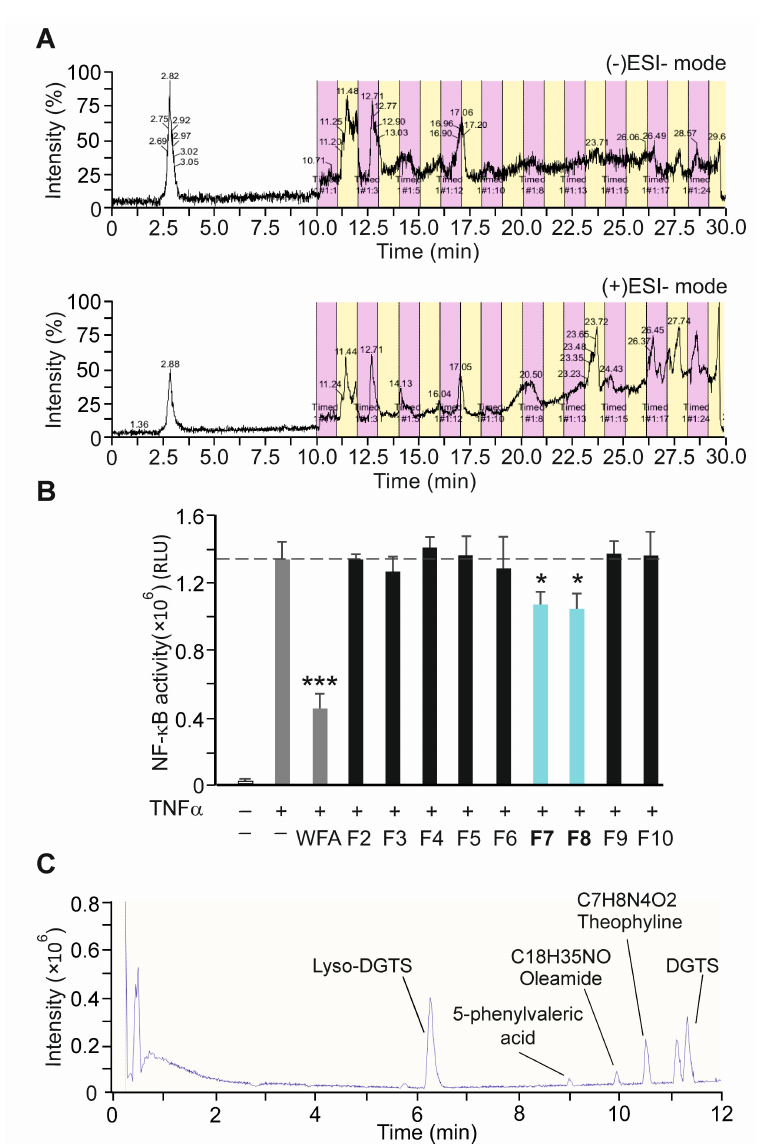
Figure 6. Bioactivity-guided fractionation of NAE_2022C and the detection of major metabolites. ( A ) Total ion HPLC-MS chromatograms of crude 2022C extract. Colored bars indicate collected fractions and corresponding peaks in positive and negative ( − )ESI and (+)ESI MS ionization modes. ( B ) The bioactivity of NAE_2022C fractions (F2–F10; 1 µ g mL − 1 ) were analyzed with the NF- κ B reporter cell-based assay, as shown in Figure 2B. Data represent means ± SD of three independent biological triplicates. * p < 0.05; *** p < 0.001 vs. samples treated with DMSO and TNF α . ( C ) UHPLC and mass spectrometry analysis of NAE_2022C active fraction (F7 + F8). Identified molecules and corresponding chromatogram peaks are